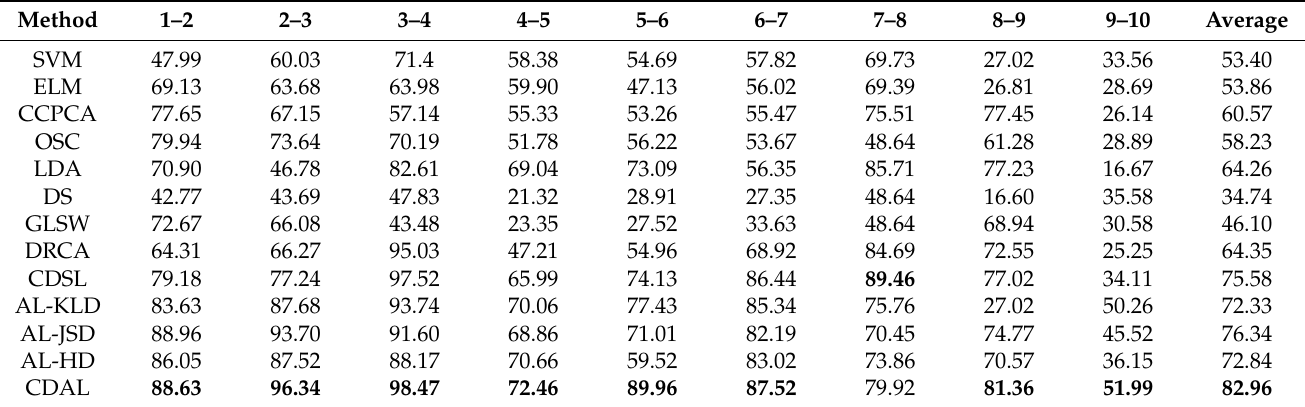
Table 4. Comparison of recognition accuracy in short-term drift (%).